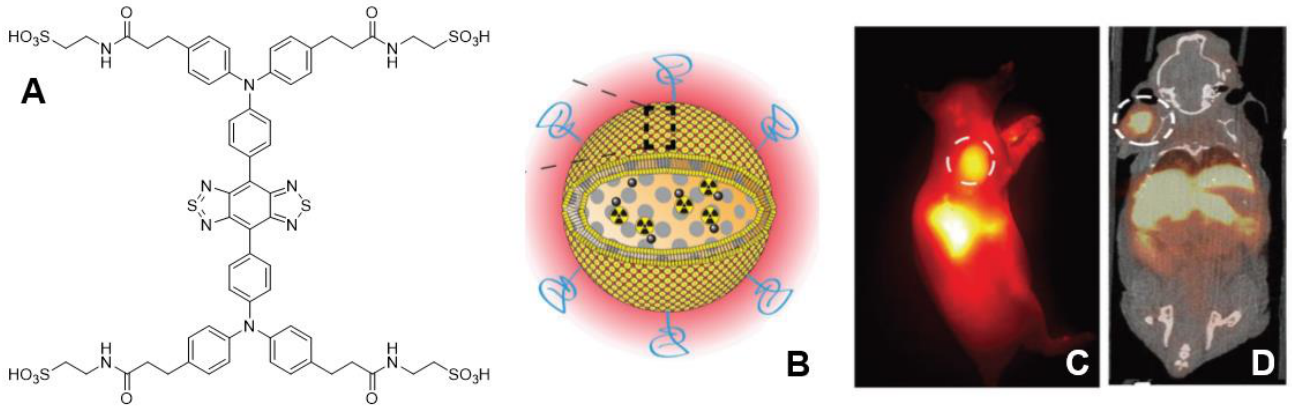
Figure 16. ( A ) Structure of the NIR-II dye CH-4T . ( B ) Schematic of overall dual-probe nanoparticle. ( C ) NIRF image in A431 xenograft tumor-bearing mouse. ( D ) PET/CT image (Reprinted from ref. [67].